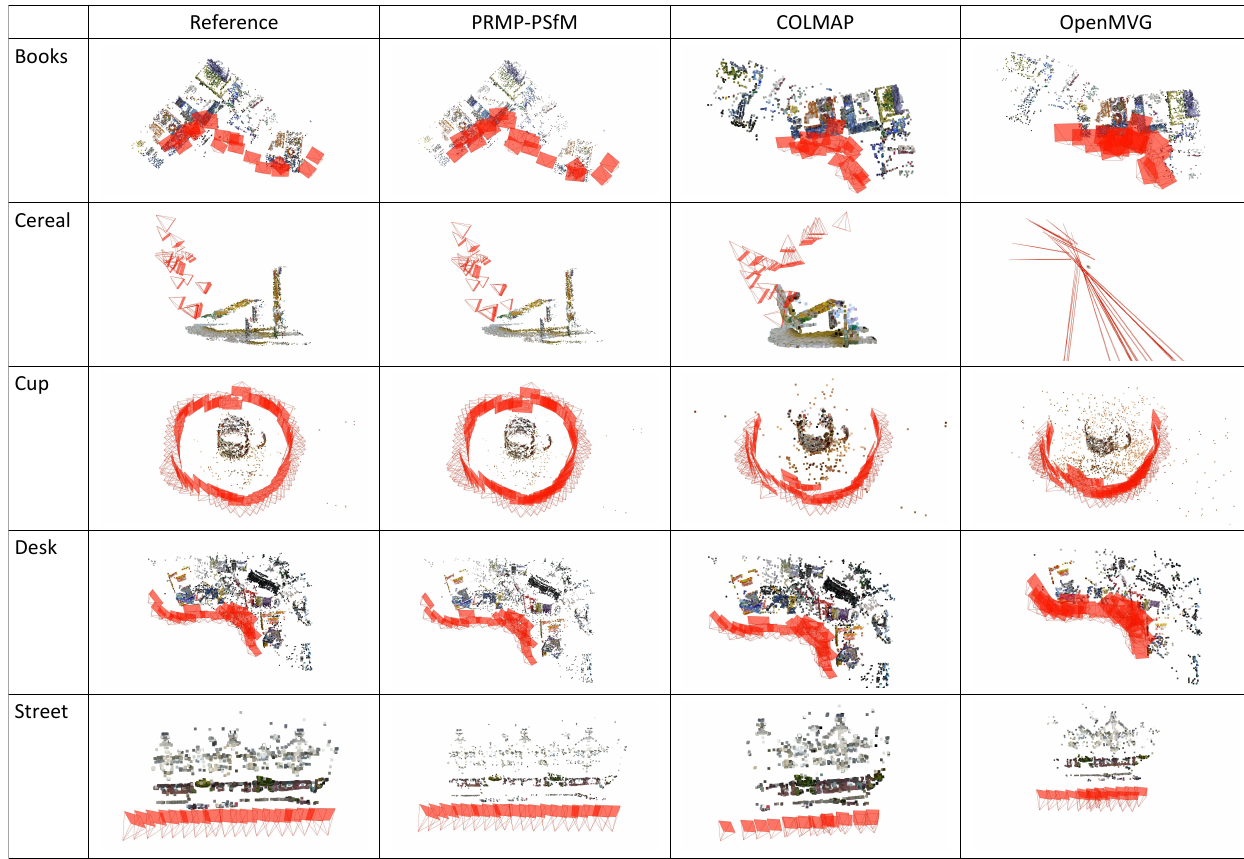
Figure 11. Reconstruction results from five small